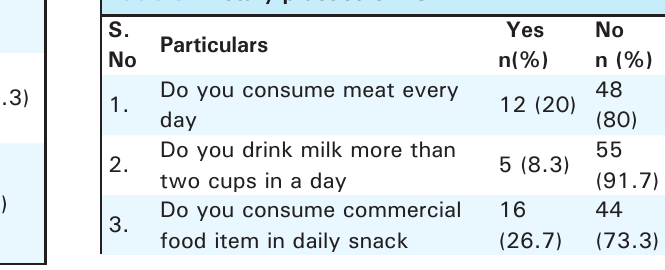
Table 3. Dietary practice of